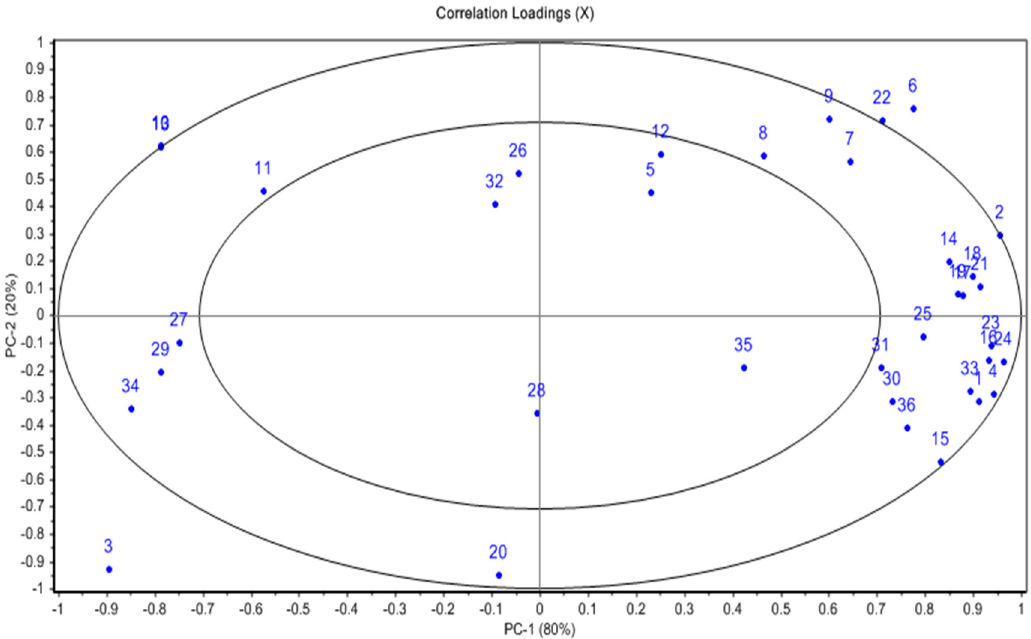
Figure 5. PCA loading plot describes all variables analyzed including polyphenols, organosulfur compounds, and associated bioactive properties.